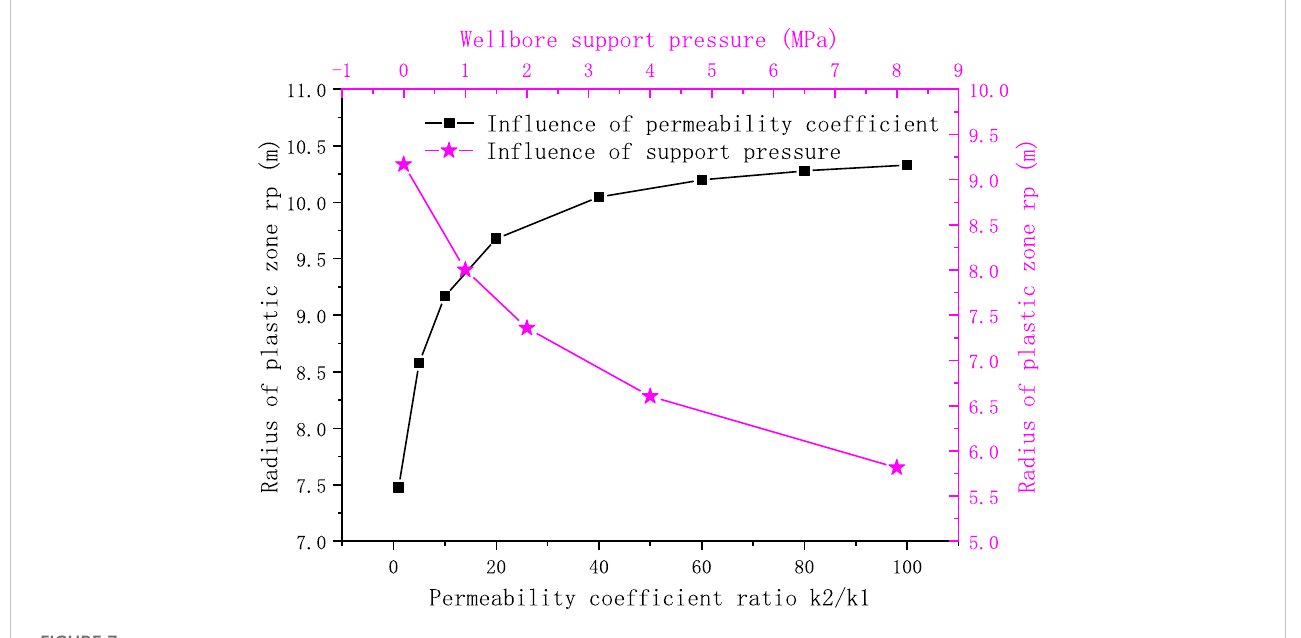
FIGURE 7 Variation of plastic zone radius with support pressure and the permeability coef fi cient